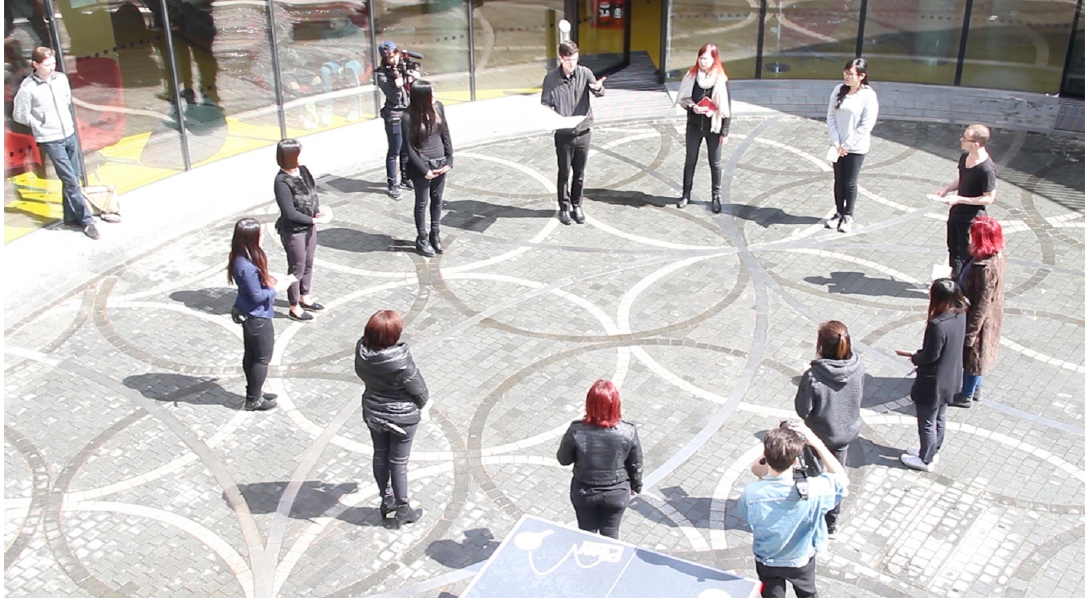
Figure 4. Translation Zone(s): A Stuttering (2016). Digital video still of participants performing in the rotunda, the basement of the Library of Birmingham